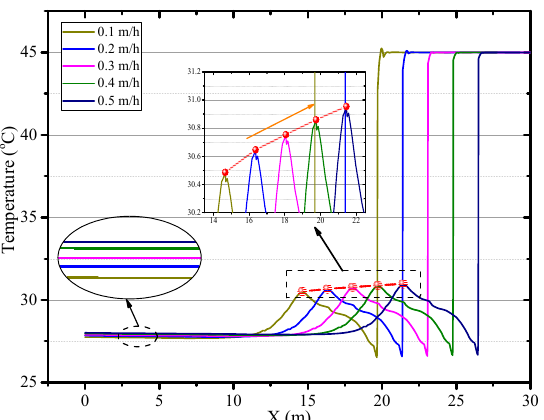
Figure 14. Air temperature distribution in Z = 0.5 m plane under different advance rate of the working face.